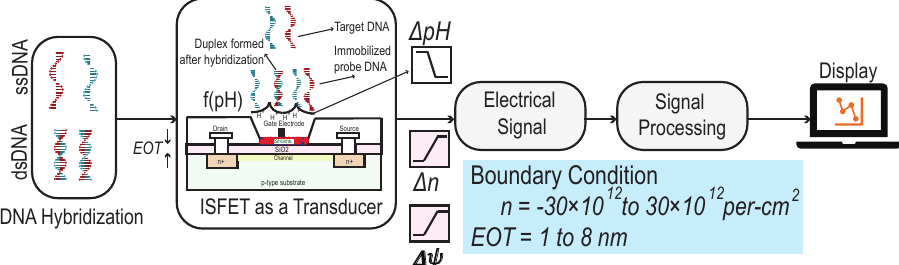
Figure 3. Schematic and block diagrammatic representation of the generation of electrical signal from the DNA